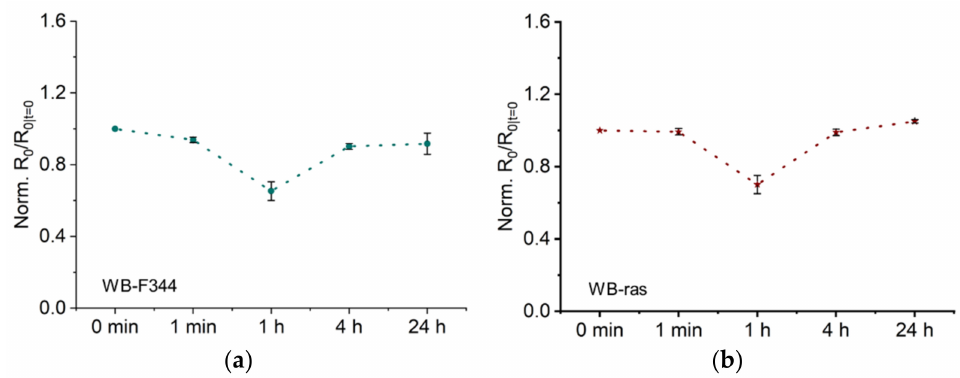
Figure 4. Low-frequency resistance R 0 as a function of time after CAP treatment of two cell monolay- ers, WB-F344 ( a ) and WB-ras ( b